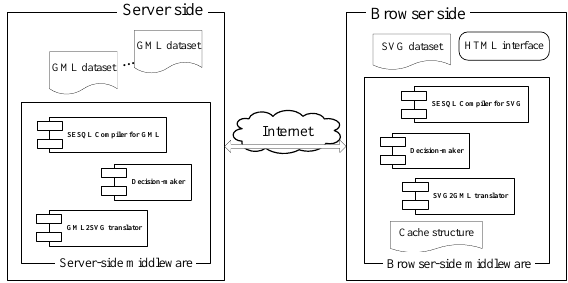
Figure 1. Architecture of the load balancing